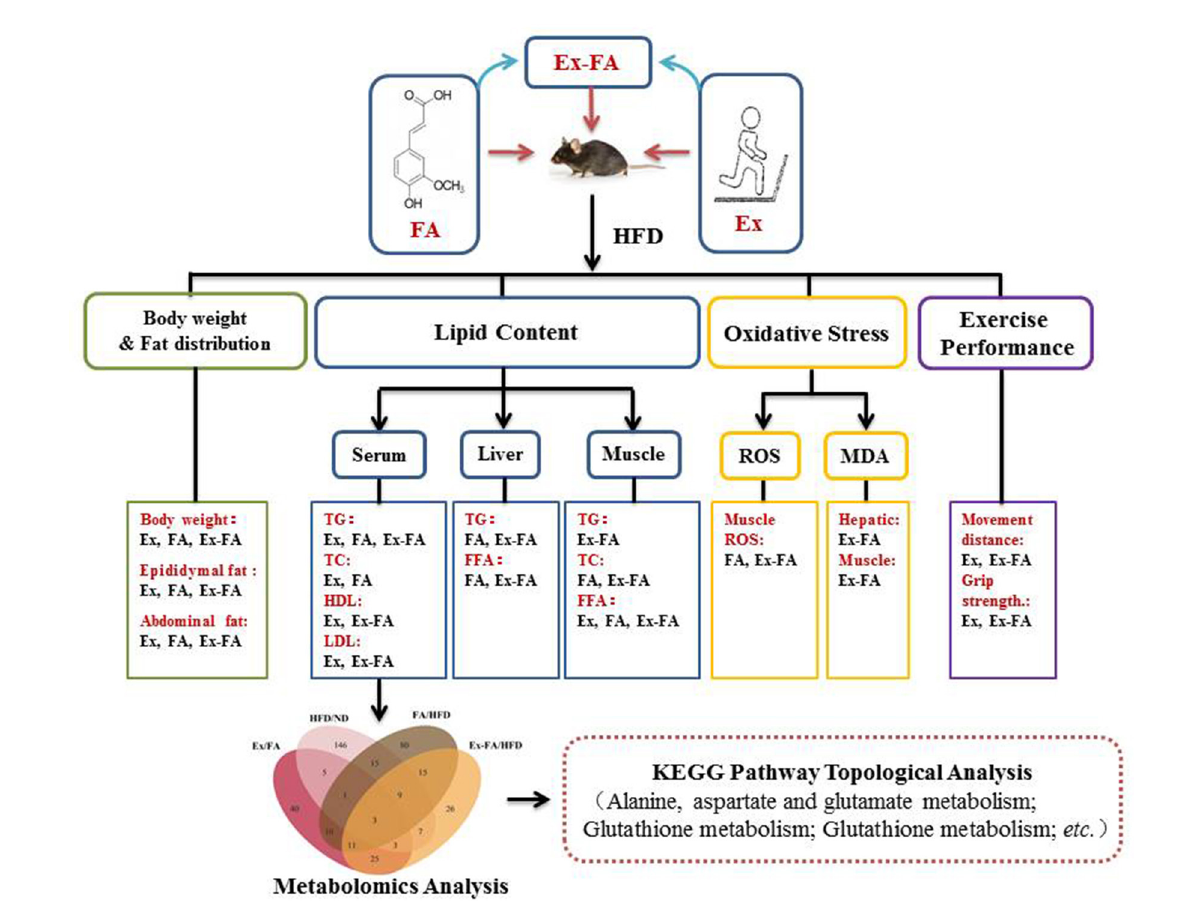
FIGURE10 A brief schematic of the regulatory effect of Ex, FA, and Ex-FA in HFD-induced mice. HFD, high-fat diet group (model); Ex, high-fat diet with exercise; FA, high-fat diet with ferulic acid; Ex-FA, high-fat diet with exercise and ferulic